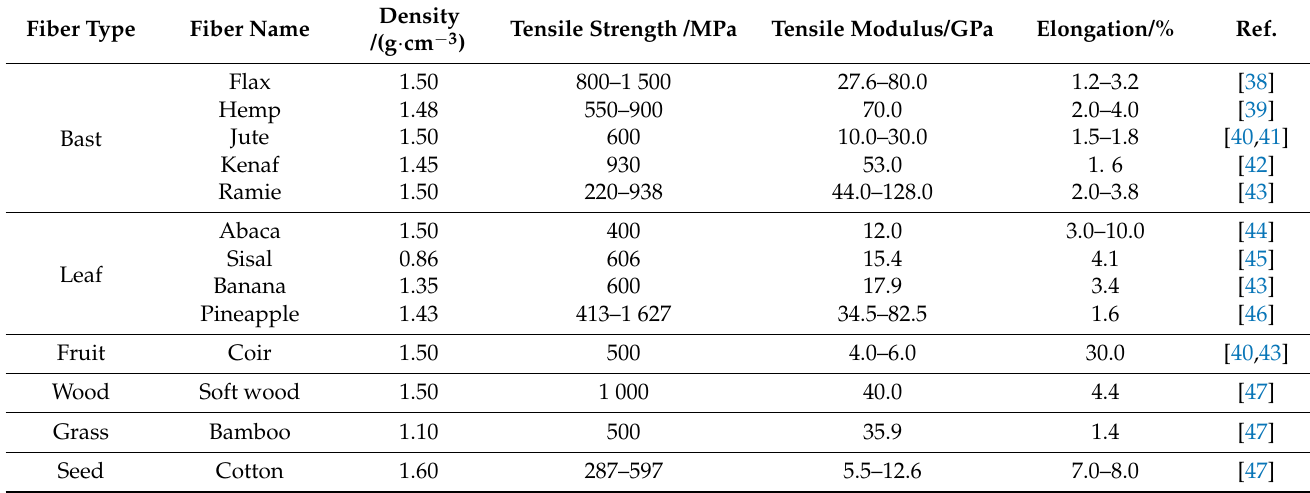
Table 1. Mechanical properties of commonly used PFs.